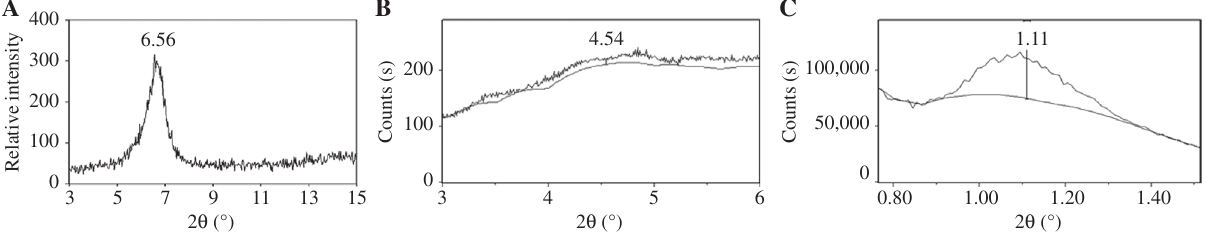
Figure 3 XRD patterns of organoclay (A), PAI-nanocomposite films 4a (B) and 4b (C).